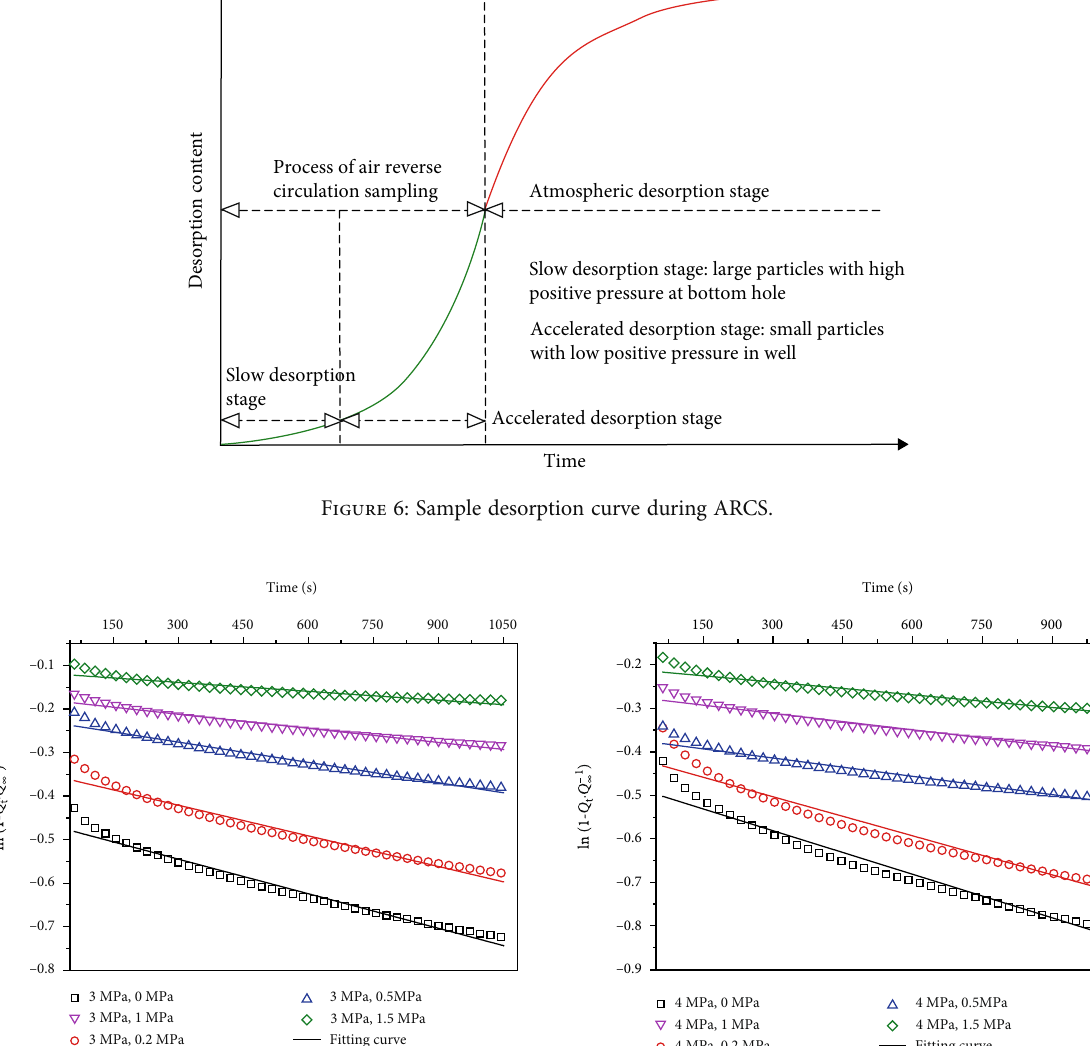
Figure 7: Relationship between ln ð 1 − Q